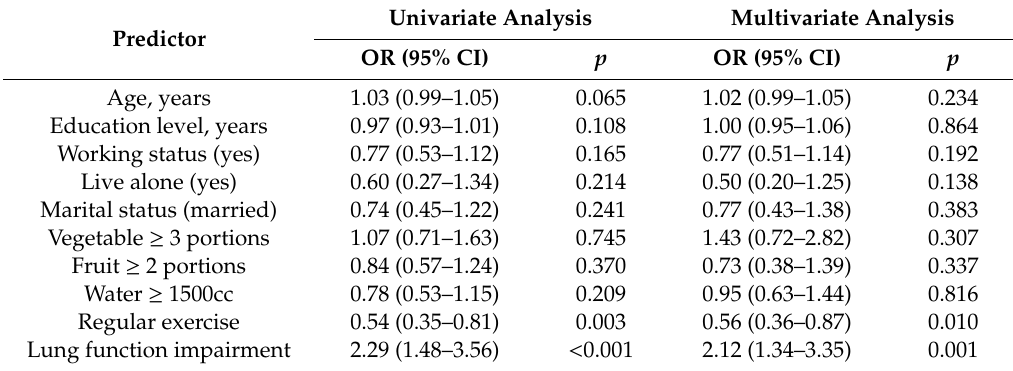
Table 3. Factors Associated with Metabolic Syndrome Among Middle-Aged